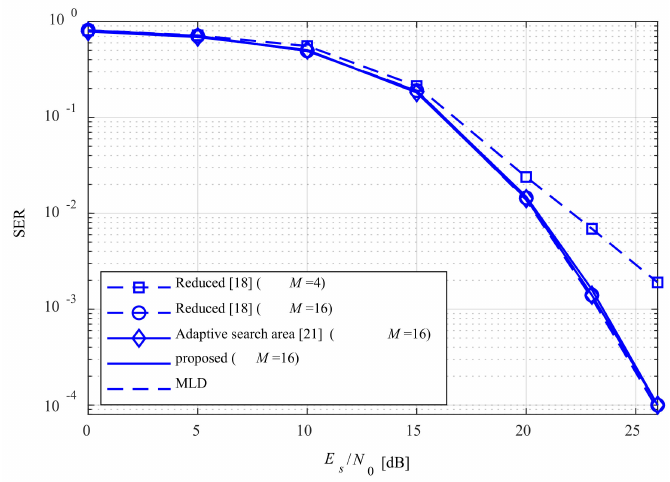
Figure 9. SER performance comparisons for N = L = 4 with 16